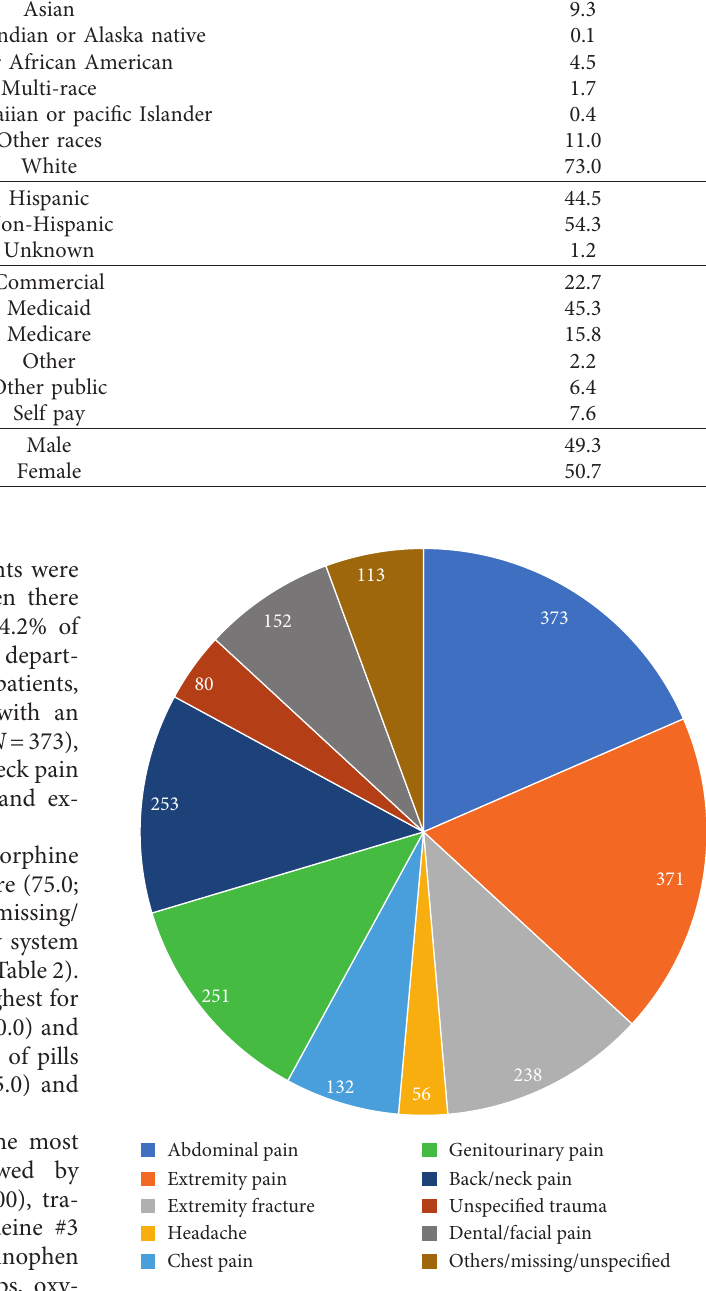
Figure 1: Opioid prescriptions by body